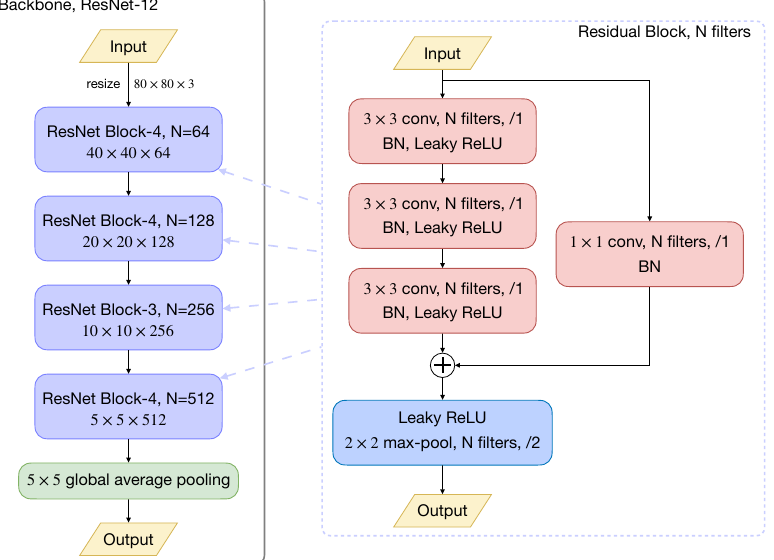
Figure 4. Illustration of the backbone architecture. The left plot shows that ResNet-12 contains four residual blocks, followed by a global average pooling (GAP) layer. Each residual block is a sequential concatenation of three {3 × 3 convolution with N filters, batch normalization (BN), Leaky ReLU (0.1)}, then a 2 × 2 max-pooling layer is applied with stride 2, shown in the right plot. The number of filters in each residual block are 64, 128, 256, and 512,